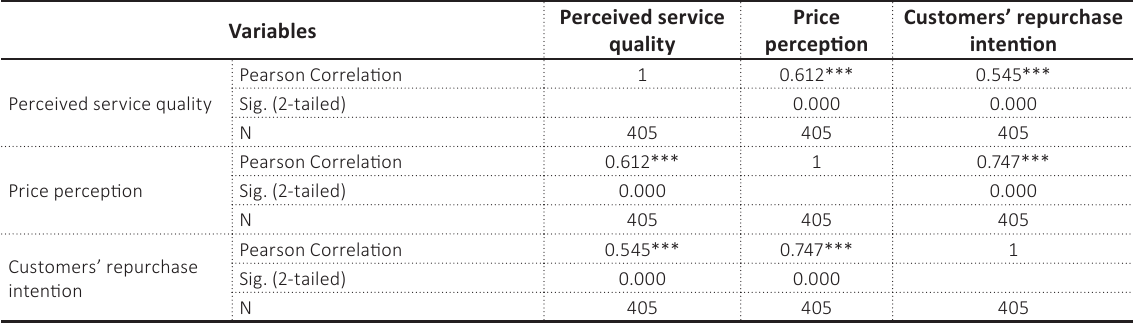
Table 4. Correlations